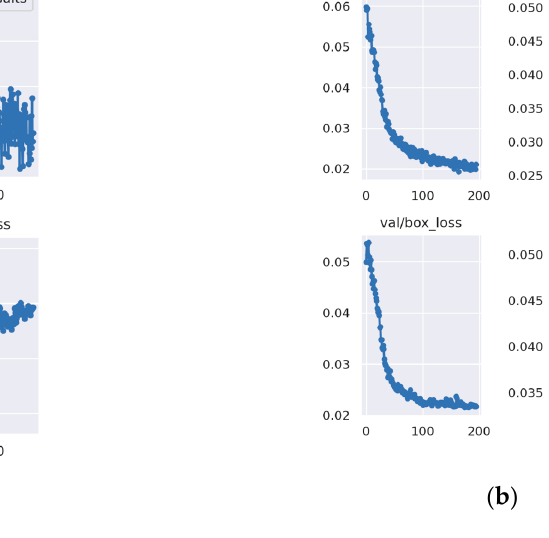
Figure 16. ( a ) Loss function before modification; ( b ) loss function after modification.